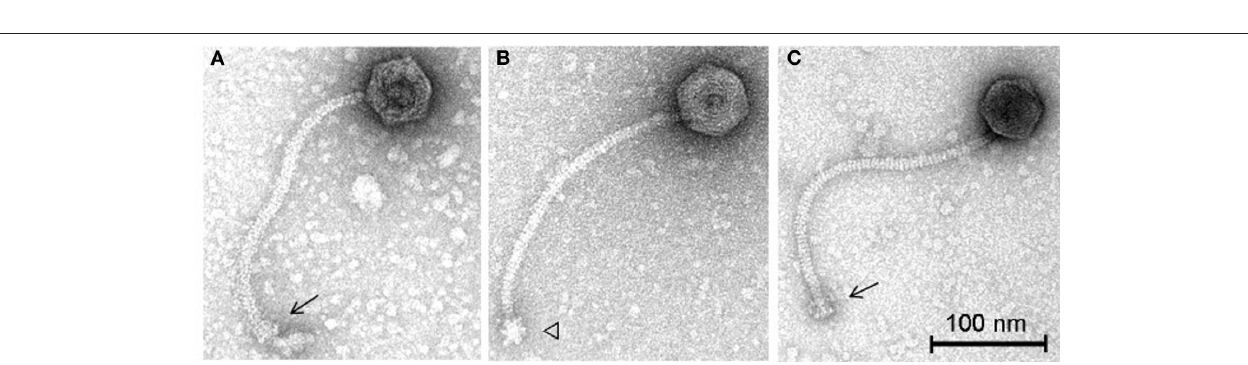
FIGURE 5 | A close comparison of the late tail genes from five serovar 4-specific phage genomes, labeled with their protein products.